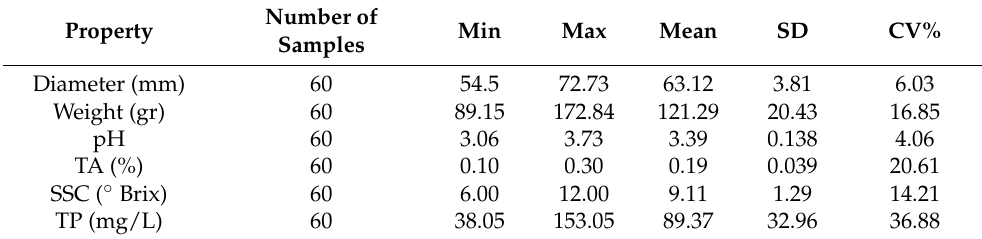
Table 2. Statistical data of Golden Delicious